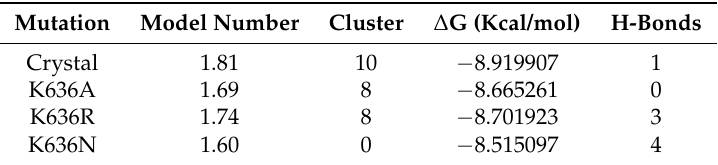
Table 1. Results for the best model from each mutation. The ∆ G obtained from the molecular docking in SwissDock and the hydrogen count obtained from